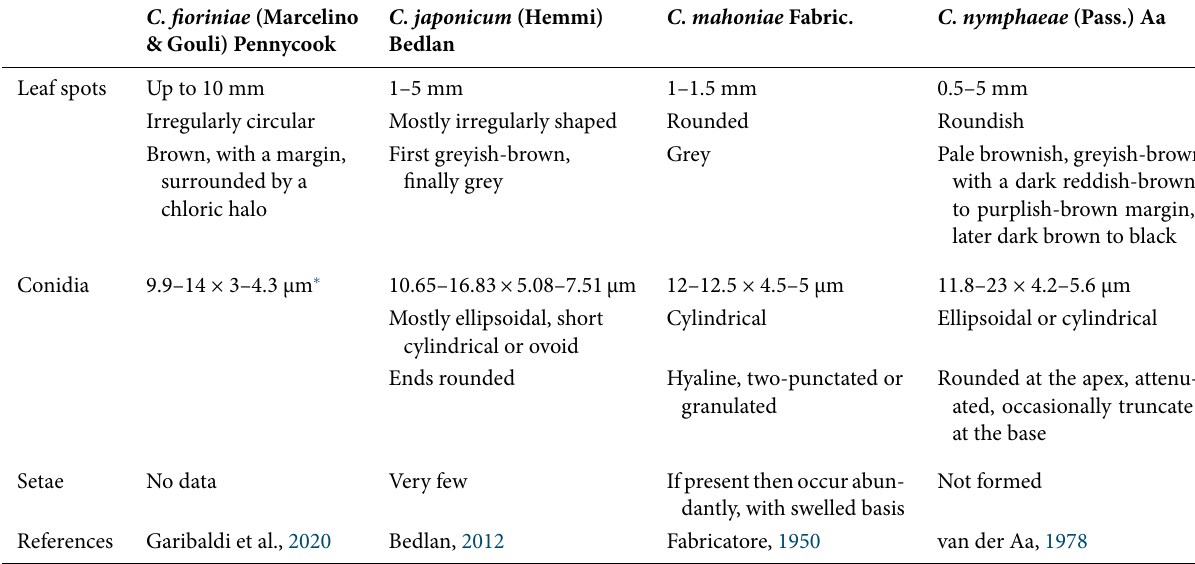
Table 1 Features of Colletotrichum species reported to be associated with Berberis aquifolium leaves.